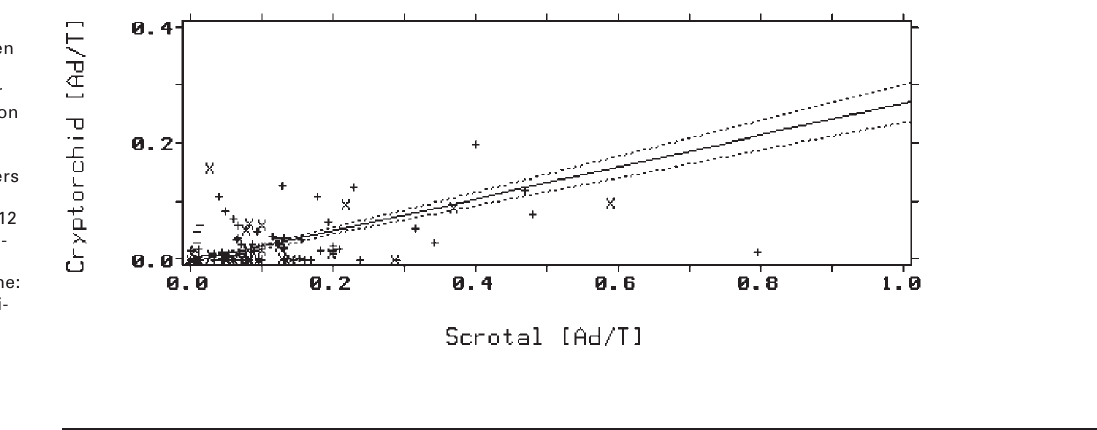
Correlation between the number of Ad spermatogonia per tubular cross section in unilateral cryp- torchid infants and their scrotal partners (–) 0–5 months, (x)